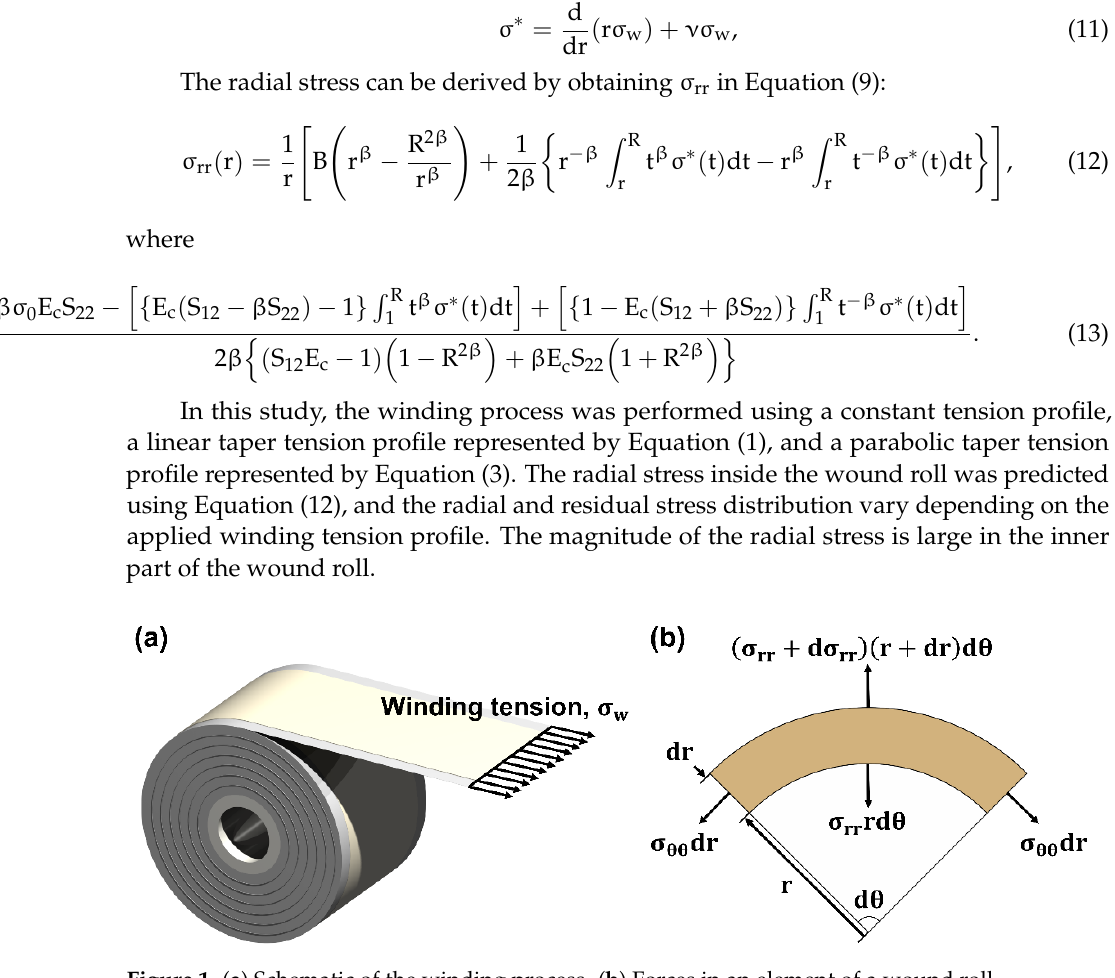
Figure 1. ( a ) Schematic of the winding process. ( b ) Forces in an element of a wound roll.